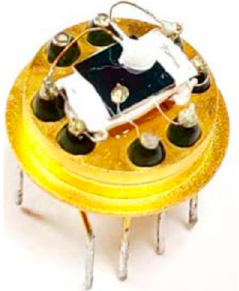
Figure 1. Capacitor sensor’s photo assembled with film resistive heater and thermistor. Package type is TO-8 (11 mm in diameter).